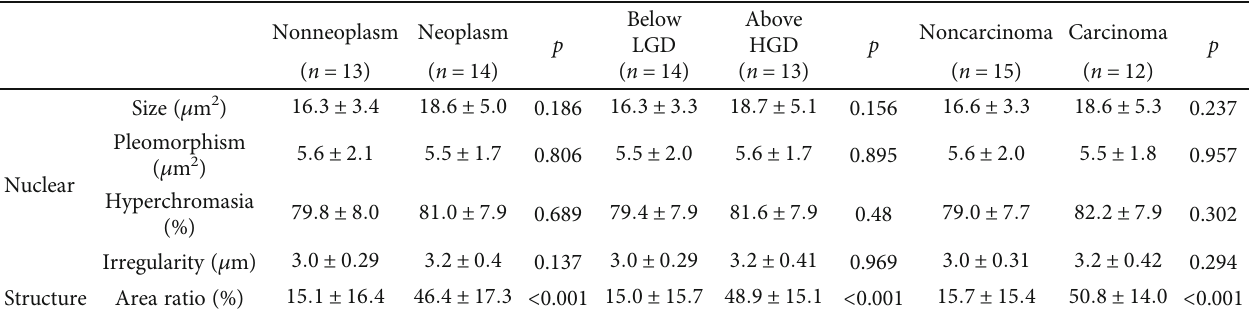
Table 3: The Results of image analysis for pathologic factors associated with nuclear and structural atypia. Nonneoplasm Neoplasm p